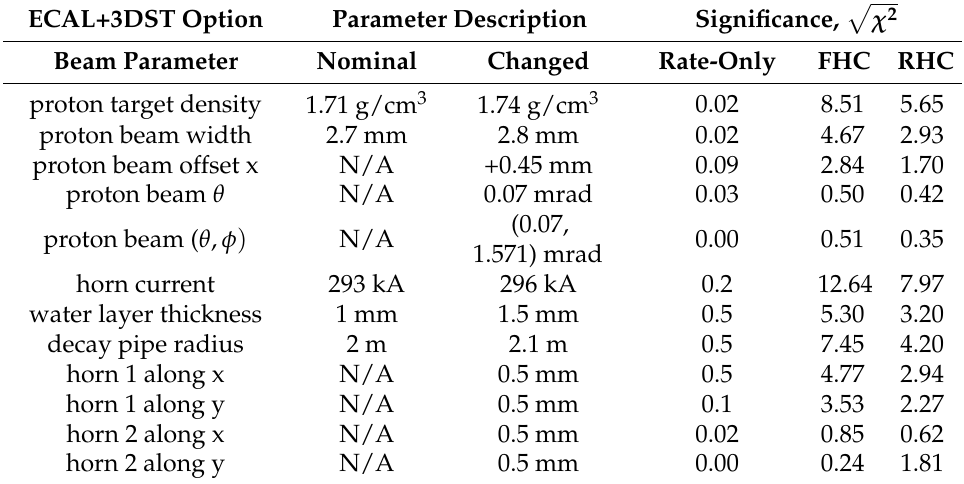
Table 18. The beam parameter description as well as the significance to the observation of a change in the beamline are shown for the 3DST+TPCs configuration. The significances are computed assuming 7-days data taking and considering neutrino interactions occurring in both the upstream barrel ECAL and within the 3DST. The GENIE 2.12 and edep-sim with GEANT4 v4.10 were used to simulate the neutrino interaction and final state particle energy deposit in the detector system. The neutrino energy reconstruction has been calculated from two contributions, the muon and the hadrons. The muons are required to travel at least 20 cm in either 3DST or TPC. The TPC momentum resolution described in Section 5.4.3 has been applied. All the hadronic energy deposits are summed calorimetrically. There is a total 2% rate uncertainty due to the proton number that is applied to the sensitivity calculation with the reconstructed neutrino energy. The sensitivity obtained that is based on the neutrino spectral information is compared to a “Rate-only” detector system consisting of four non-magnetized 7-ton modules that measure the beam rate and profile at 0, 1, 2, 3 m from the on-axis position at the ND site. This work is further described in [155]. ECAL+3DST Option Parameter Description